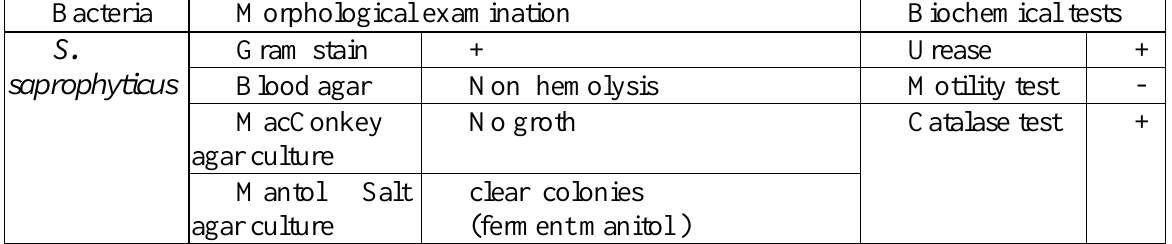
Table (1): Morphological and biochemical tests of S . saprophyticus